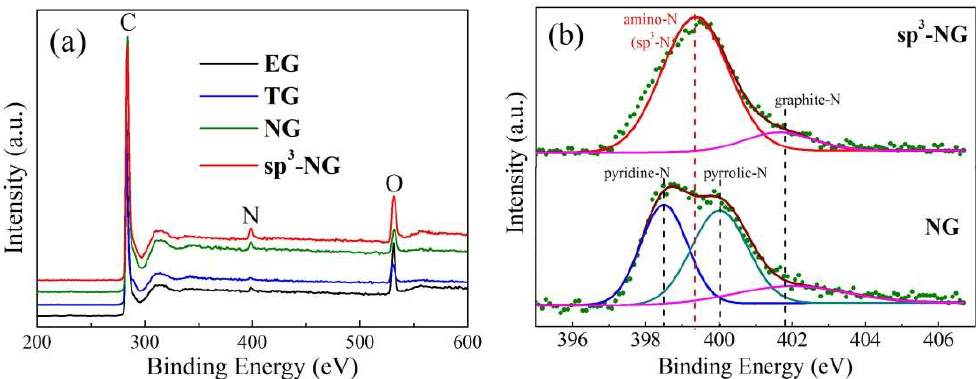
Figure 3. ( a ) XPS spectra of EG, TG, NG, and sp 3 -NG; ( b ) Typical fine-scanned XPS spectra of N 1 s of NG and sp 3 -NG. Blue, green, magenta, and red subpeaks are ascribed to pyridinic-, pyrrolic-, graphite- and amino-type (sp 3 -type) N–C bonding, respectively.